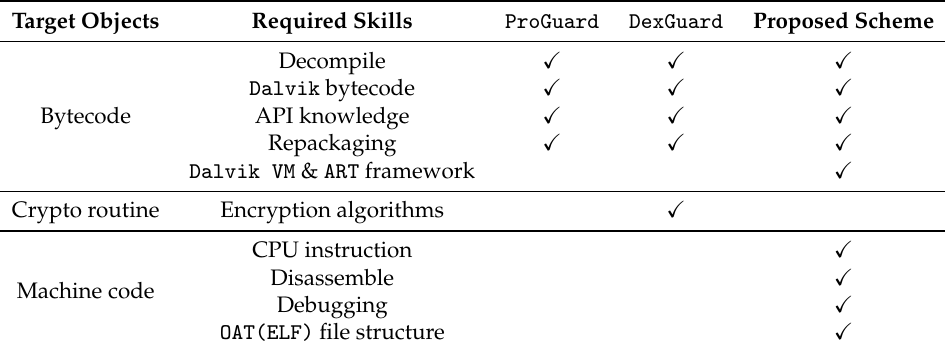
Table 2. Required reversing skills to analyze protected code.